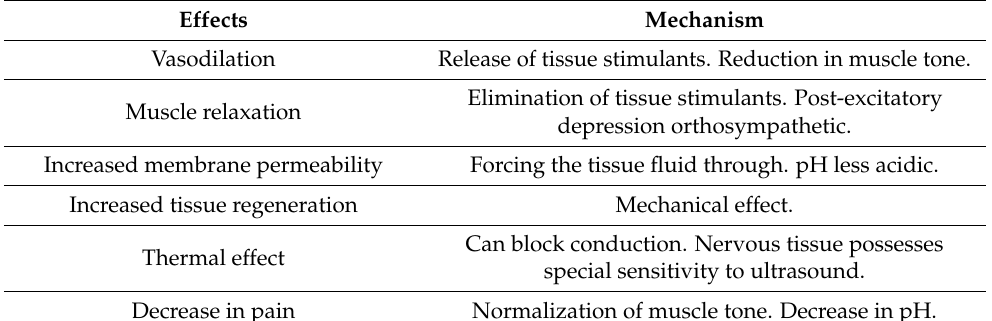
Table 2. The absorption of ultrasound energy produces the following effects [15]. Effects Mechanism Elimination of tissue stimulants.